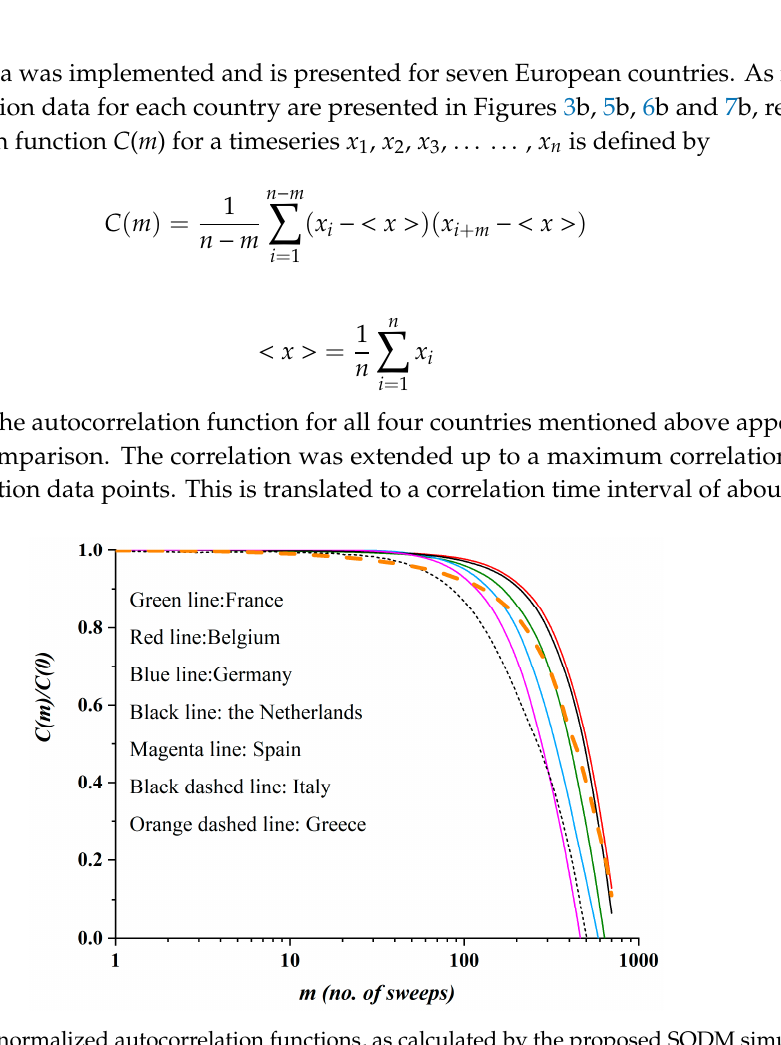
Figure 11. The normalized autocorrelation functions, as calculated by the proposed SODM simulation data; France is shown by the green line, Belgium by the red line, Germany by the blue line, the Netherlands by the black line, Spain by the green line, Italy by the black dashed line and Greece by the orange dashed line. A classification of the countries according to the extent of restrictive measures is apparent.